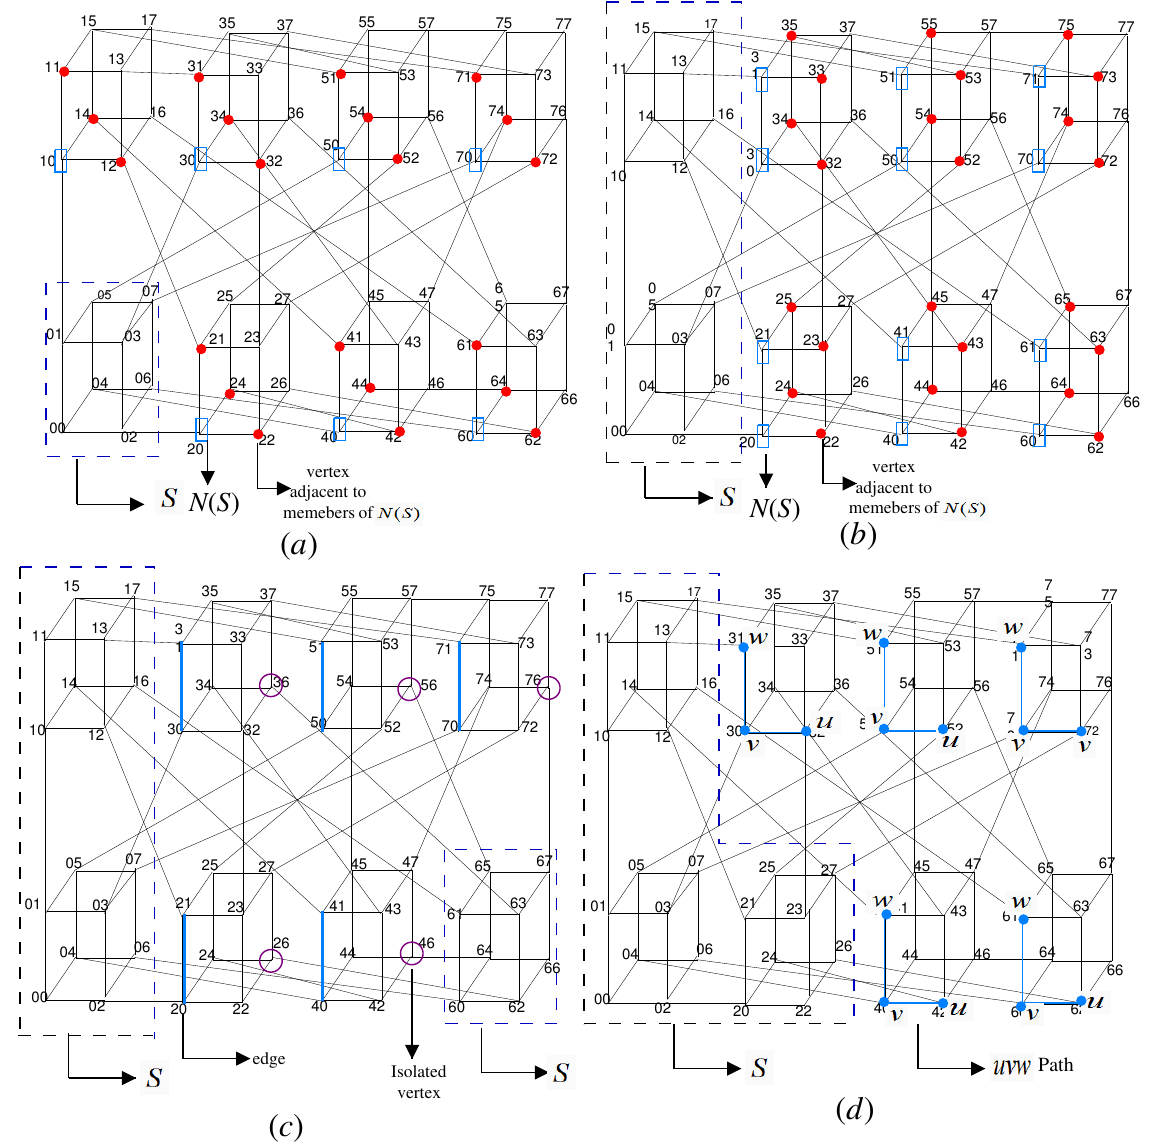
Figure 2. Circled vertices indicates in ( a – d ) be a PDS of H 2